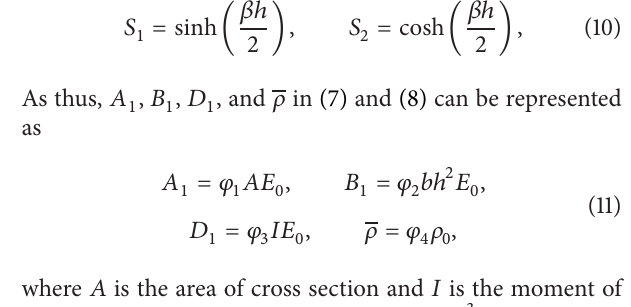
where 𝛽 is a positive or negative constant characterizing the material gradient, 𝐸 0 , 𝜇 0 , and 𝜌 0 are the values of those elastic properties of the middle layer (𝑦 = 0) . Since Poisson’s ratio presents a very limited influence on SIFs [22], Poisson’s ratio ] is taken as a